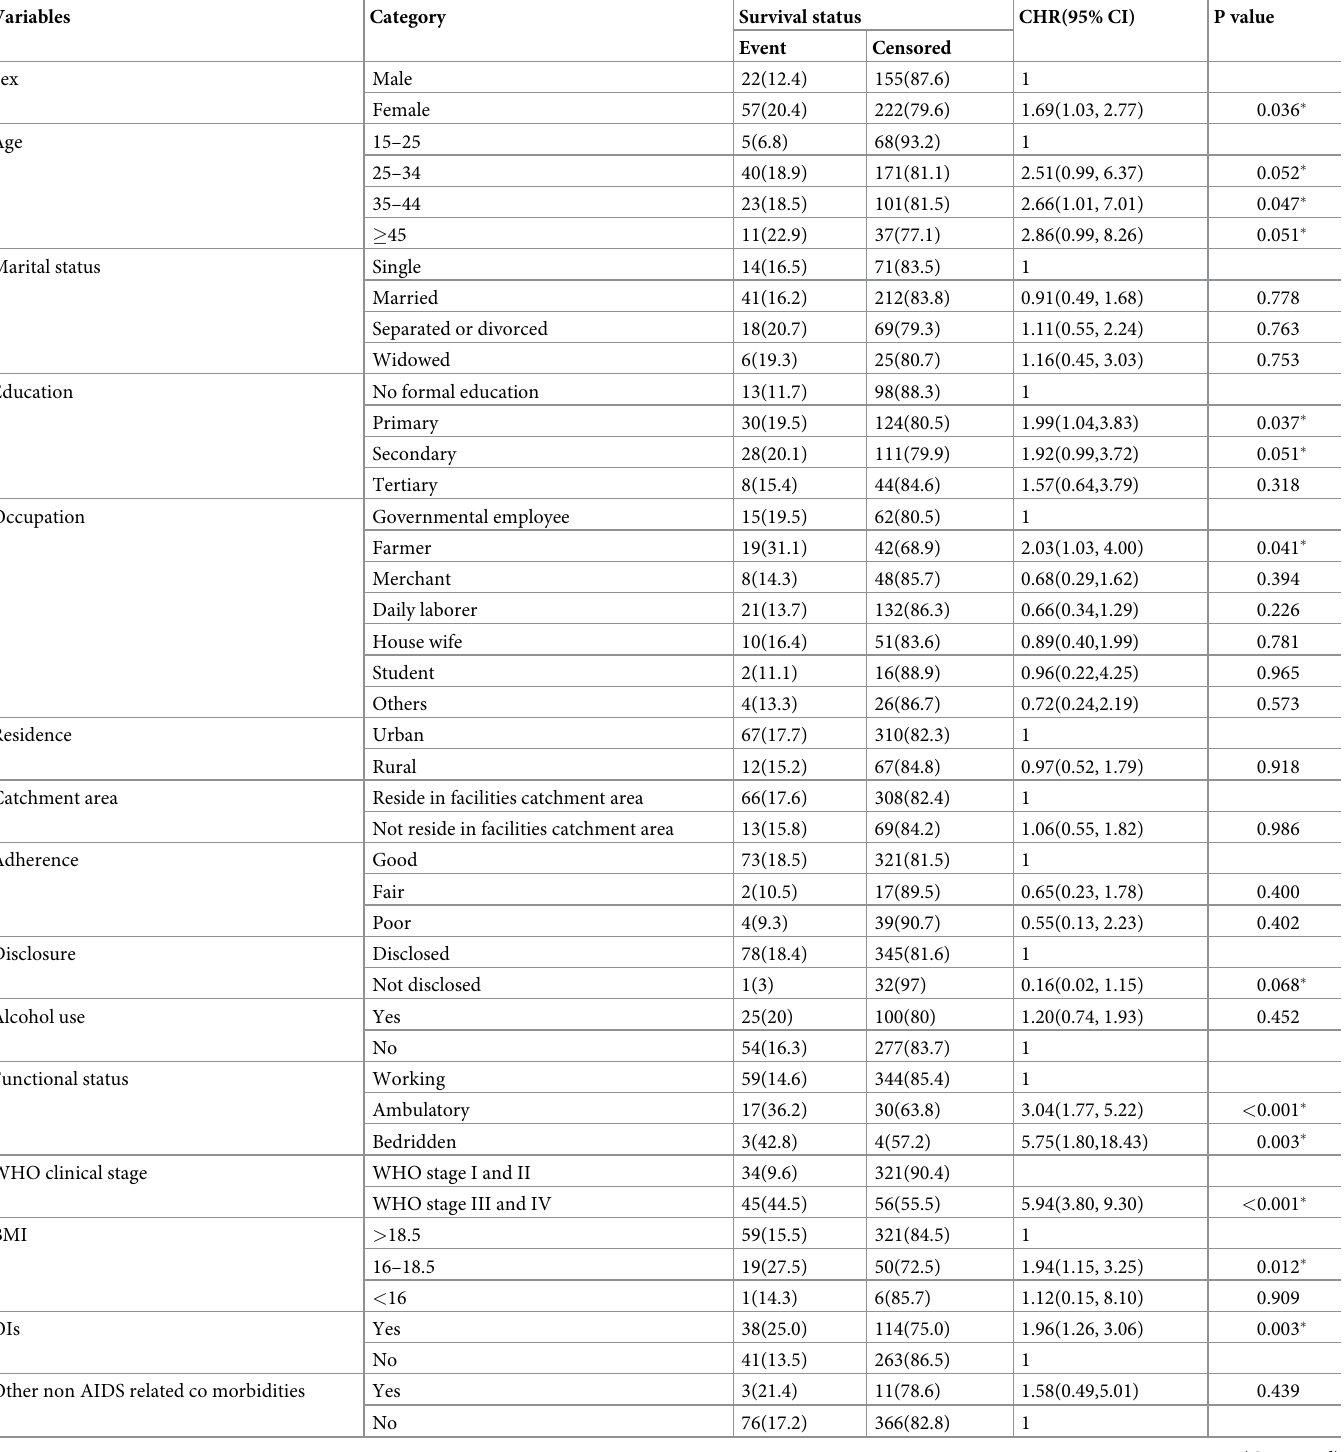
Table 7. Bi-variable Cox regression for predictors of ADRs among HIV positive adults on ART at Arba Minch town public health facilities, January 2013 to Decem- ber